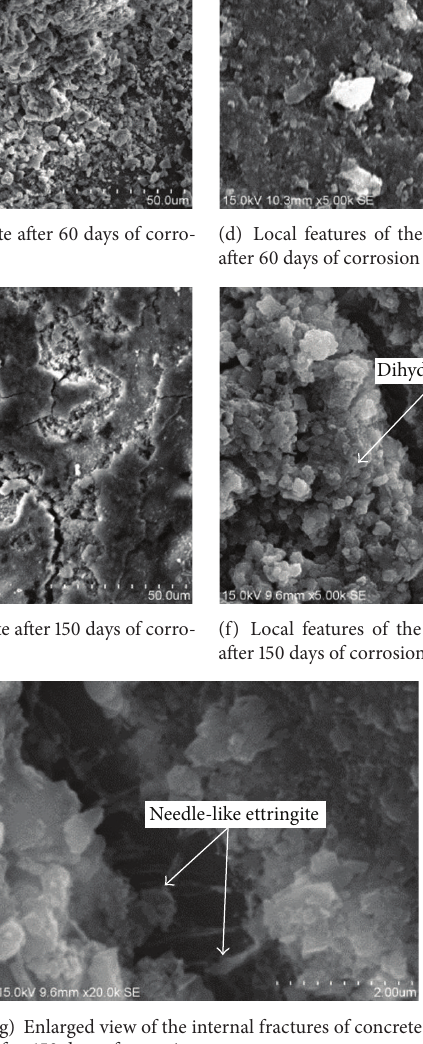
Figure 5: Micromorphology of